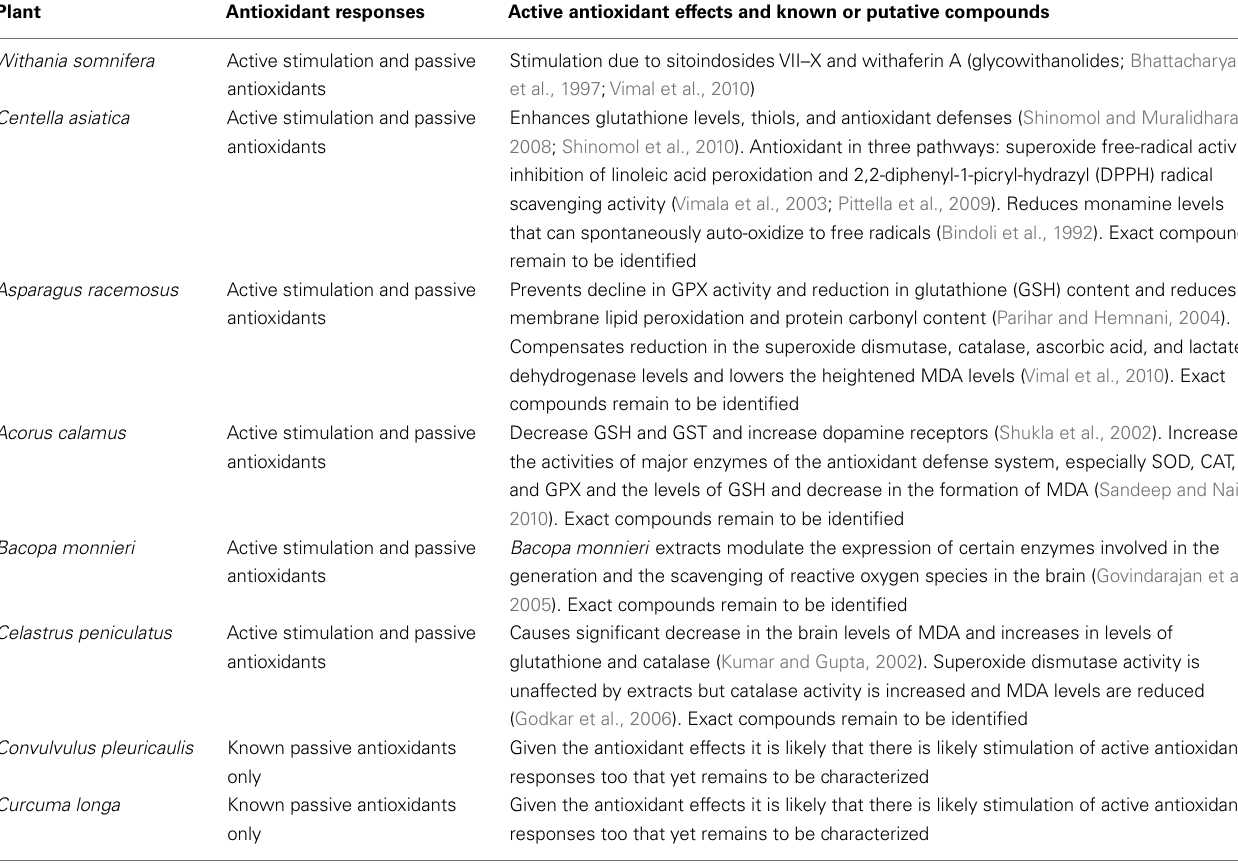
Table 1 | Plants with known or likely antioxidant stimulating